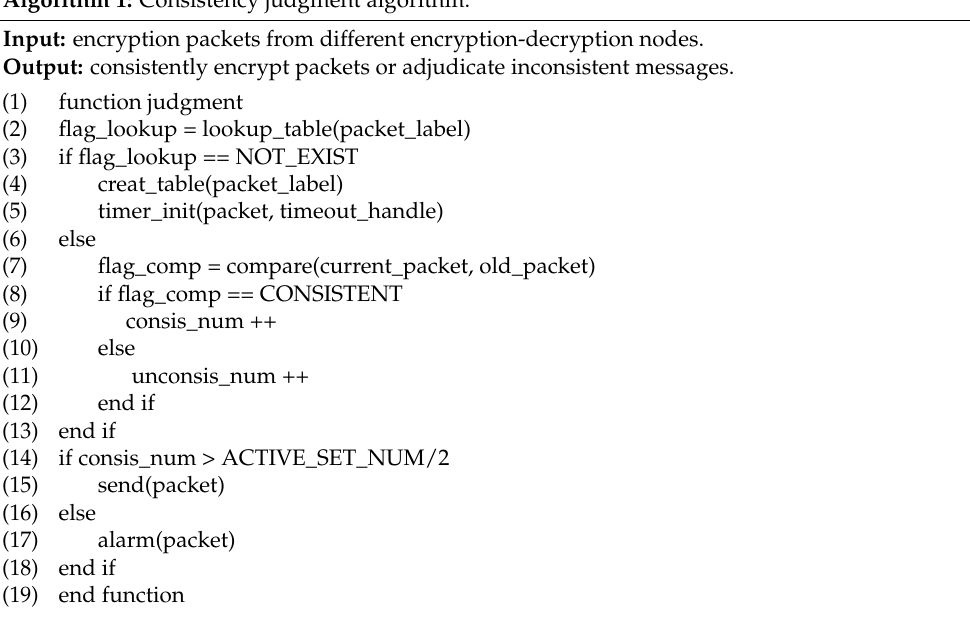
Algorithm 1: Consistency judgment